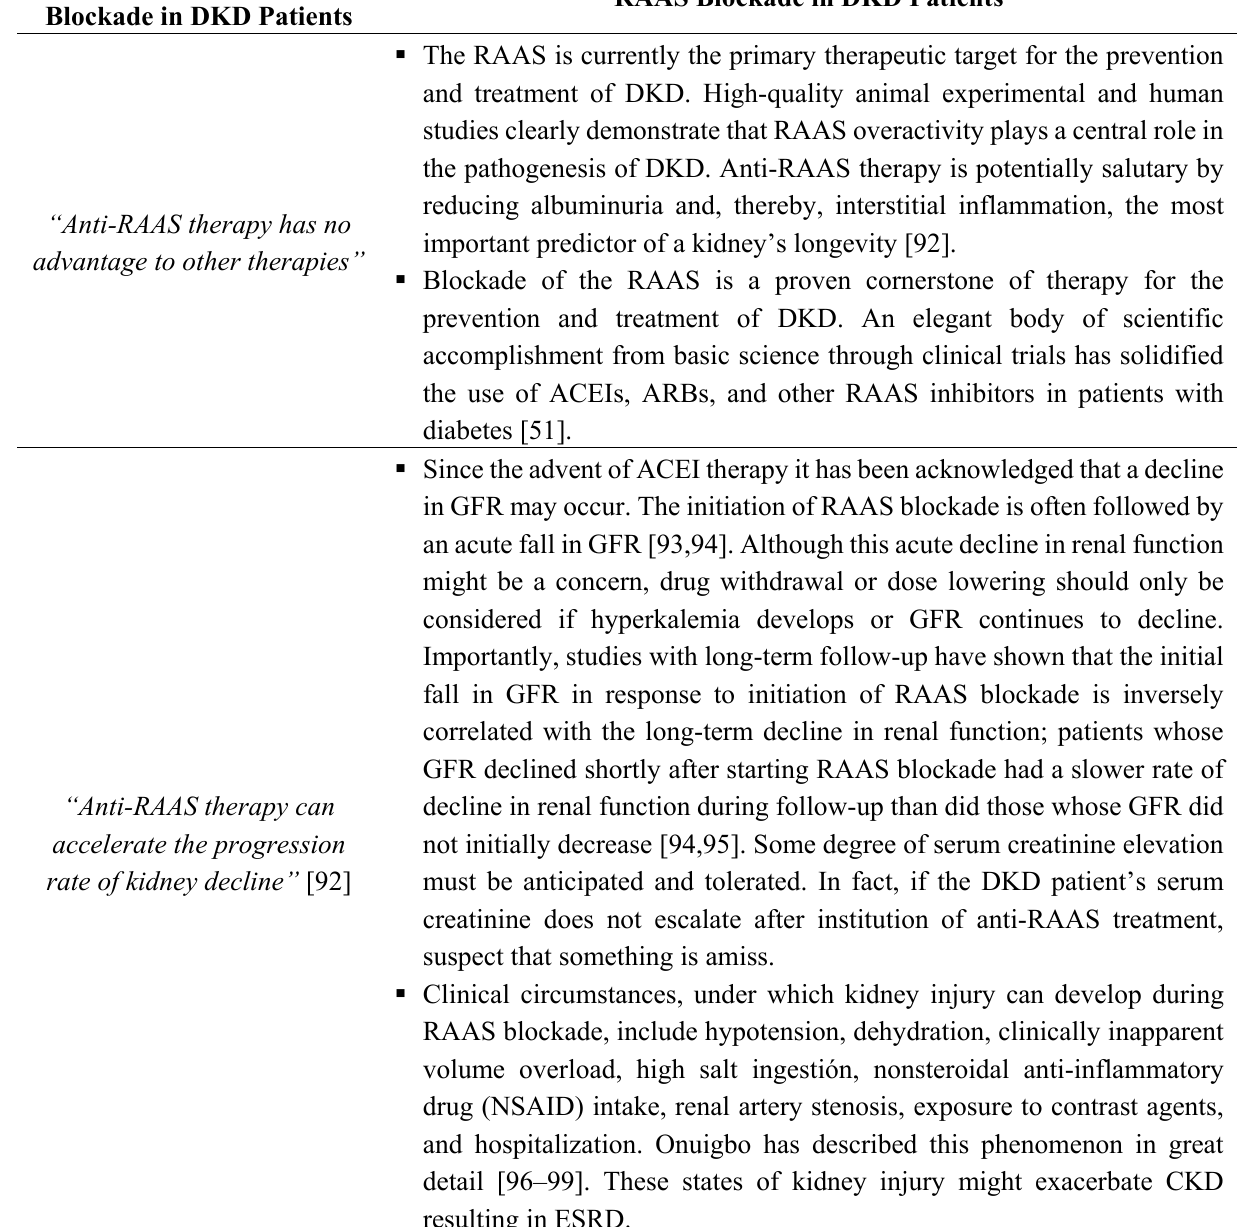
Table 2. Main reasons wielded by some clinicians not to use RAAS blockade in DKD patients. Reasons Wielded by Some Clinicians Not to Use